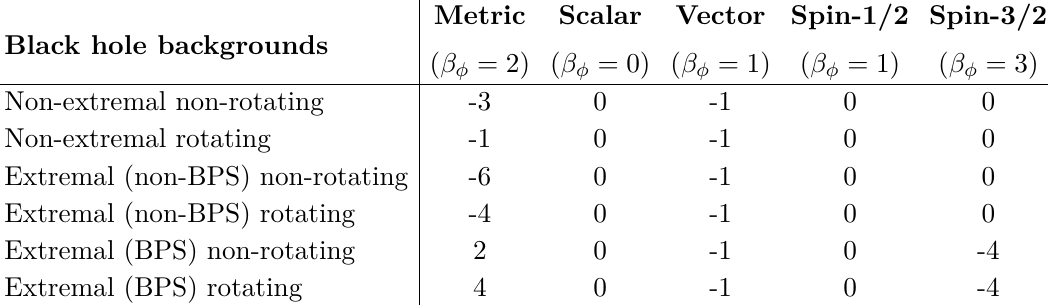
Table 2. List of zero-mode number n 0 for different fluctuations around the 4D black hole back- φ grounds. The values of the scaling dimension parameter β φ are mentioned in the corresponding columns. The negative values for the AdS 4 and extremal near-horizon backgrounds arise from the renormalized finite part of the zero-mode integral (2.10) [16, 25–28, 84].